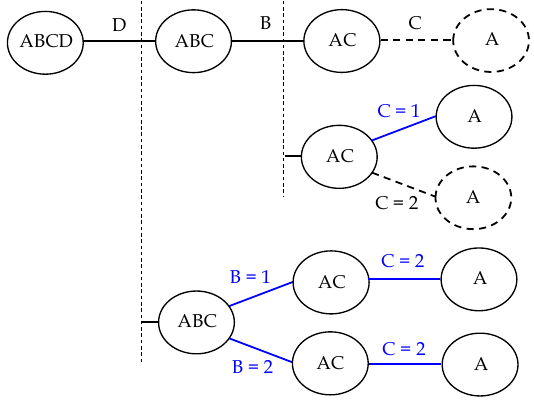
Figure 3. Tree graph for the analysis of the effect of the possible values of factor A (initial position of the obstacle) on the expected accuracy performance of the filter. Dashed nodes and arcs correspond to rejected conclusions due to multimodal populations. Arcs in blue denote decisions on the value of factors based on interactions that are forced by us to get unimodality in the data. Here, “1” and “2” refer to specific levels of the factors.